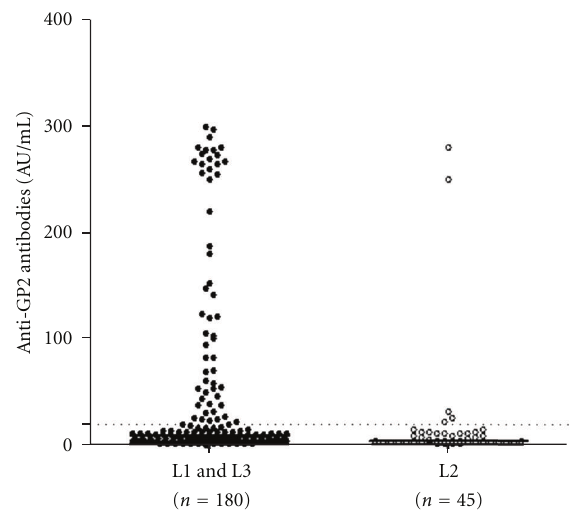
Figure 2: Anti-GP2 antibody titres in 225 patients with Crohn’s disease (CD) stratified in two groups: patients with restricted colonic location (L2) and patients with ileal (ileal or ileocolonic) location (L1 and L3), according to Montreal